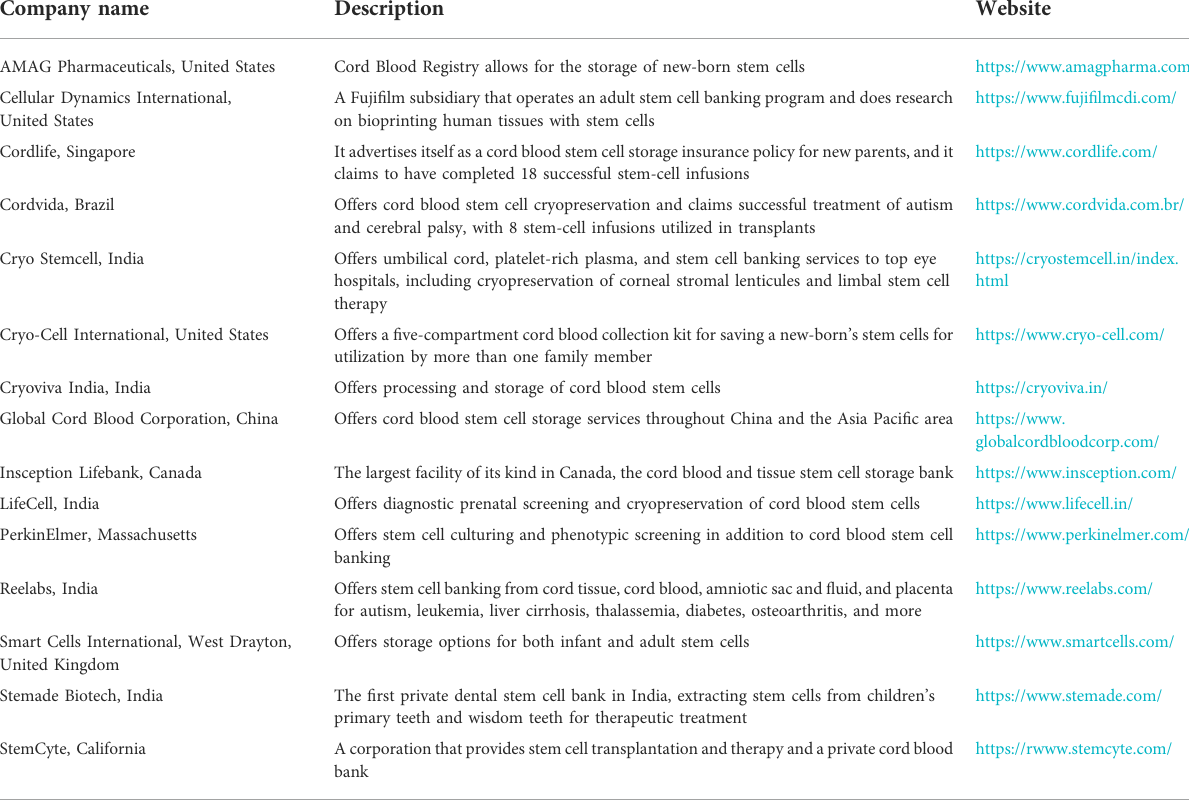
TABLE 4 Lists the companies involved in stem cell banking and treatment